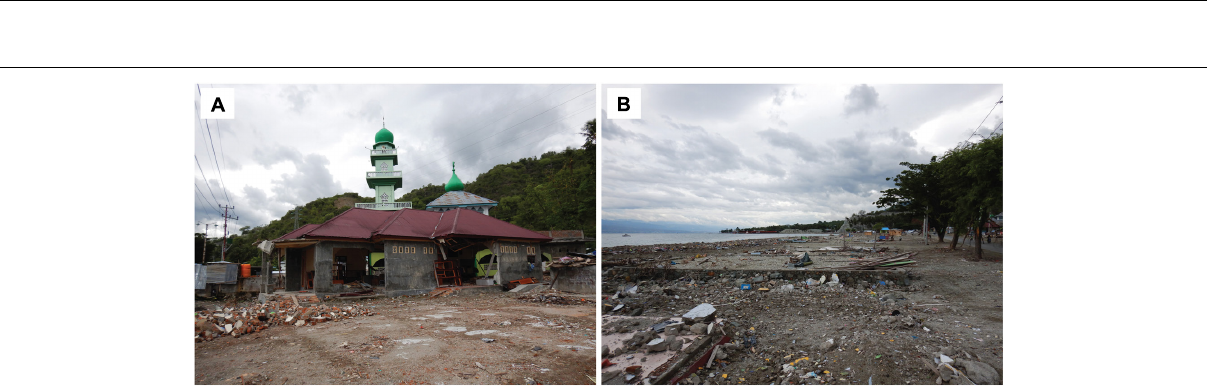
FIGURE 8 | (A,B) Tsunami-devastated area on the western coast of Palu Bay (point 2 in Figure 2 ).